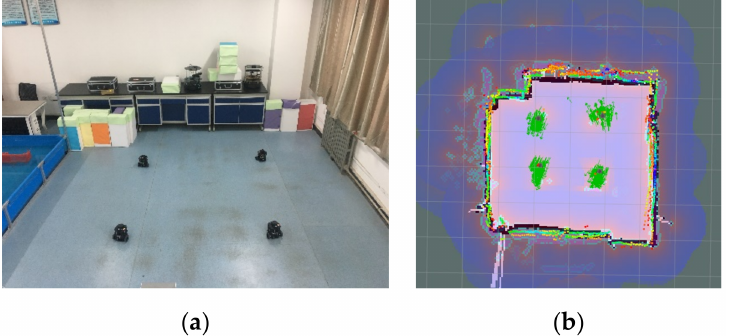
Figure 16. Multi-robot formation experiment environment: ( a ) real scene; ( b ) RVIZ scene.